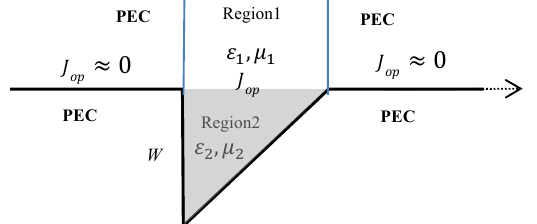
Fig.2. Substituting upper half-space above a 2-D large IRTG with two parallel PEC